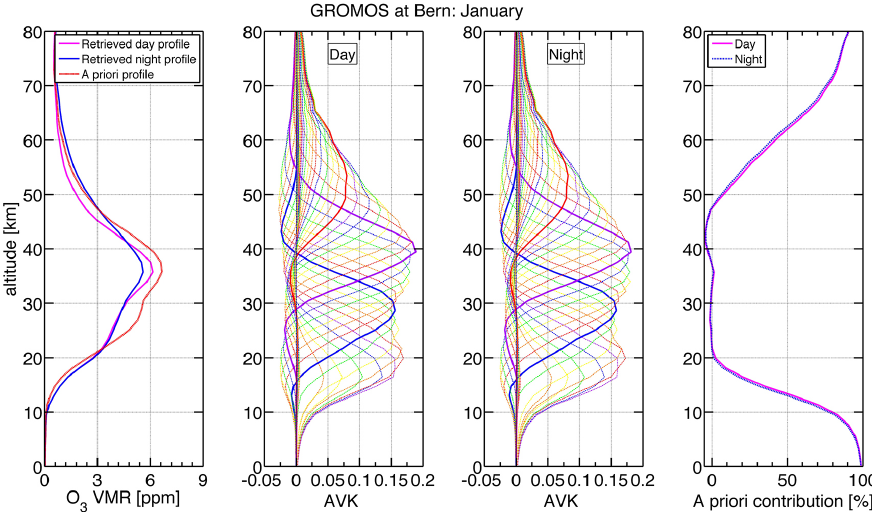
Figure 2. The left panel shows the averaged GROMOS daytime (magenta) and nighttime (blue) profiles for January 2010 as well as the a priori profile (red). The two middle panels depict the daytime and nighttime averaging kernel (AVK) matrices. The a priori contribution is shown in the right panel for daytime (magenta) and nighttime